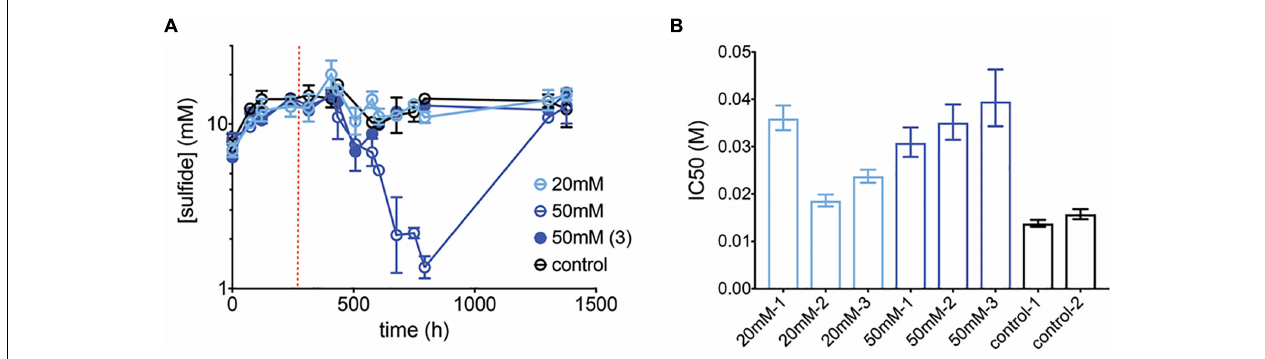
FIGURE 7 | (A) Average sulfide production in control (black circles) and treated (blue circles) pure-culture D. sp. BMSR chemostats. Chemostats treated at 50 mM did not replicate each other and hence both trajectories are shown (replicates 1–2: open circles, replicate 3: closed circle). Dashed line indicates start of treatment. Error bars represent SD of replicates. (B) IC50 values for all chemostats, measured at final time-point. Error bars represent the 95% CI of the IC50